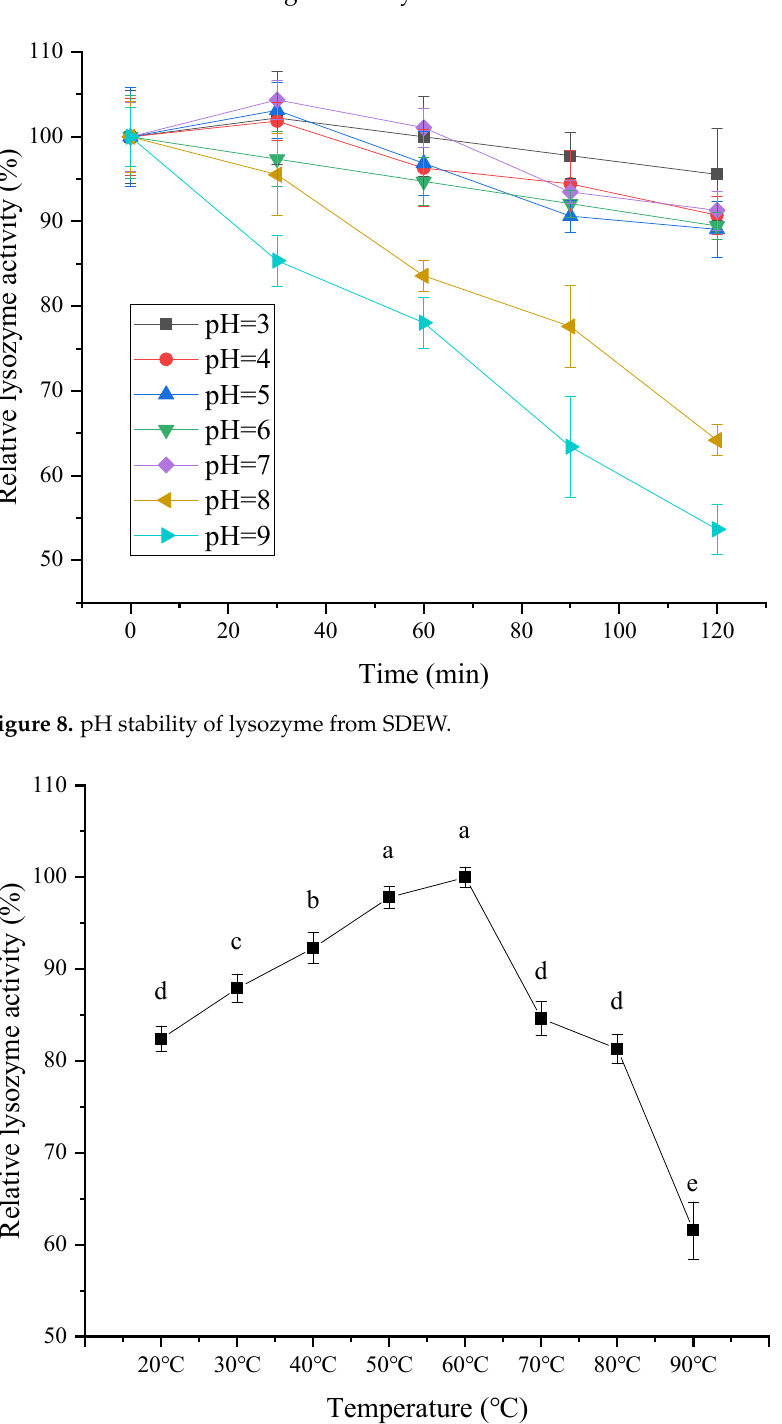
Figure 7. Effect of pH on activity of lysozyme from SDEW.